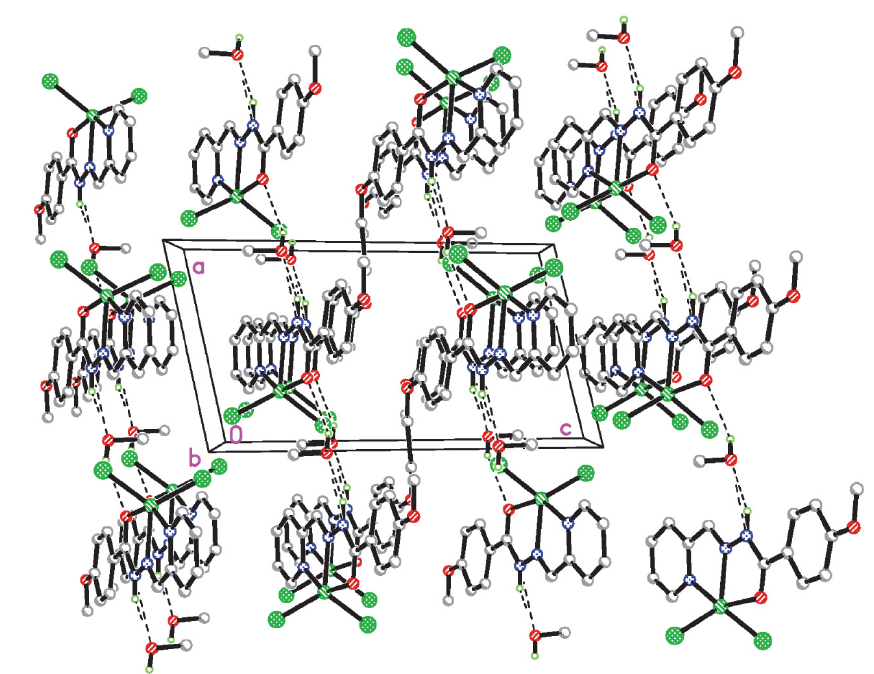
Figure 6. Molecular packing structure of 2 , viewed along the b axis. Hydrogen bonds are shown as dashed